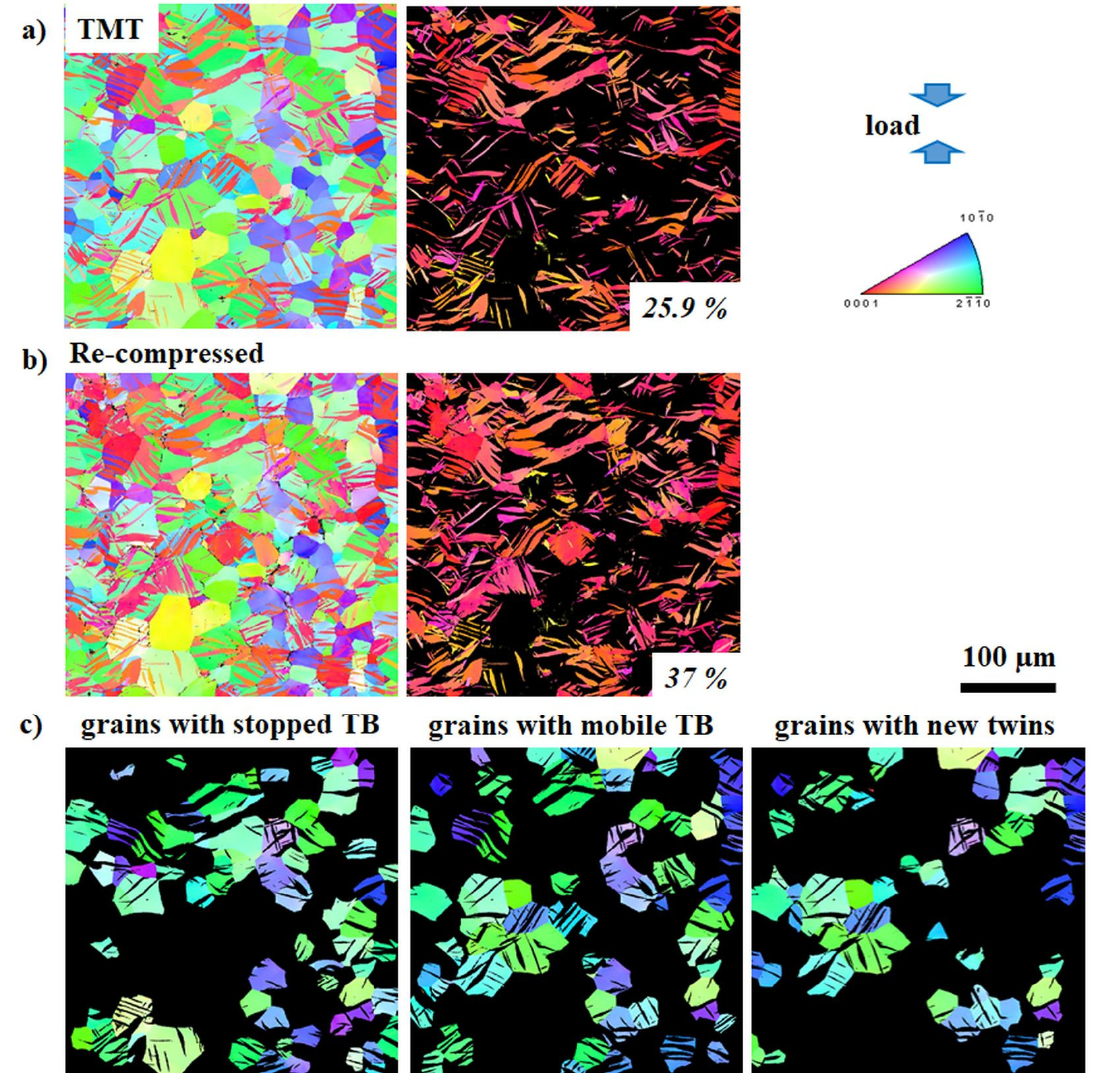
Figure 7. Orientation maps (entire microstructure and twins only) of the ZN10 alloy in the TMT state ( a ) and subsequent loading in compression up to 3% of strain ( b ). Orientation maps for grain grouping for TMT samples with respect to TB mobility ( c ). Color code for orientation maps represents orientation with respect to ED.